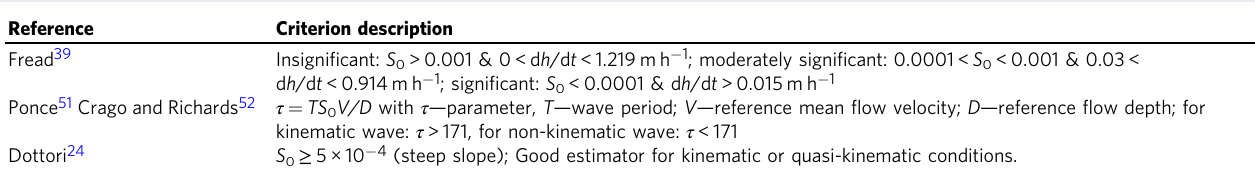
Table 1 Hysteresis diagnostic formulas 4 . Reference Criterion description